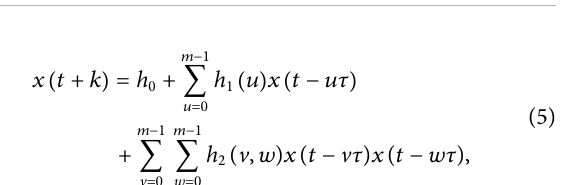
TABLE 1 | Four error metrics of three individual chaotic prediction models. MAE RMSE SDofAE CC S